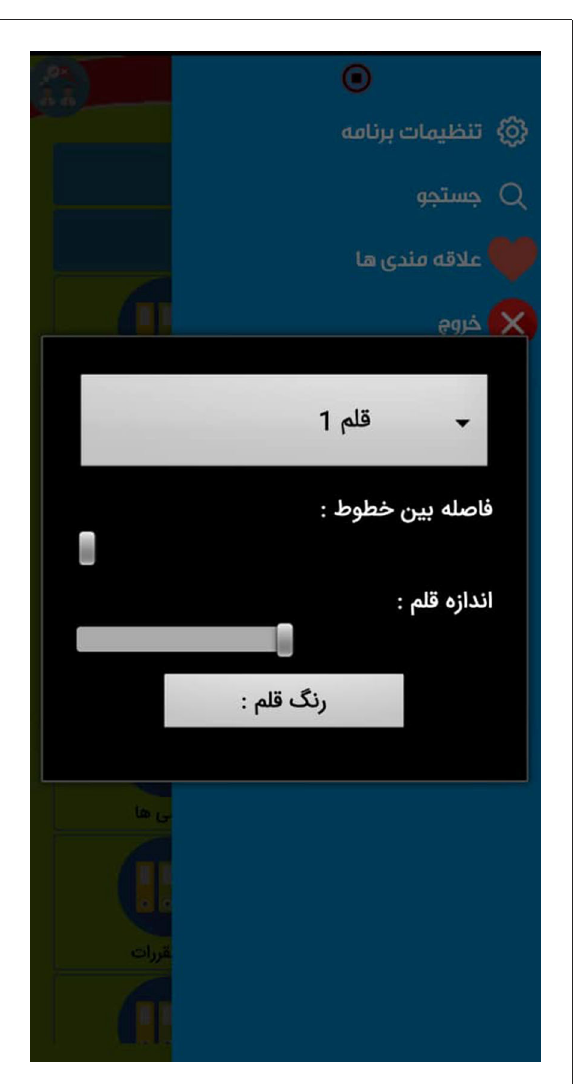
FIGURE4 The part of the internal environment of